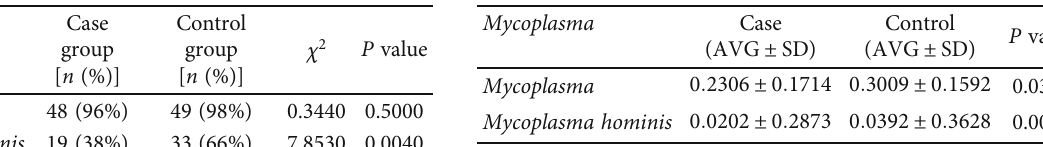
Figure 9: Screening of the di ff erential functions using the KEGG pathway. The abundant signal pathways in the case group are represented by pink bars, and the abundant signal pathways in the control group are represented by blue bars. Table 4: A comparison of the positive detection rate of Table 5: A comparison of the average relative abundance of Mycoplasma between the 2 groups. Mycoplasma between the 2